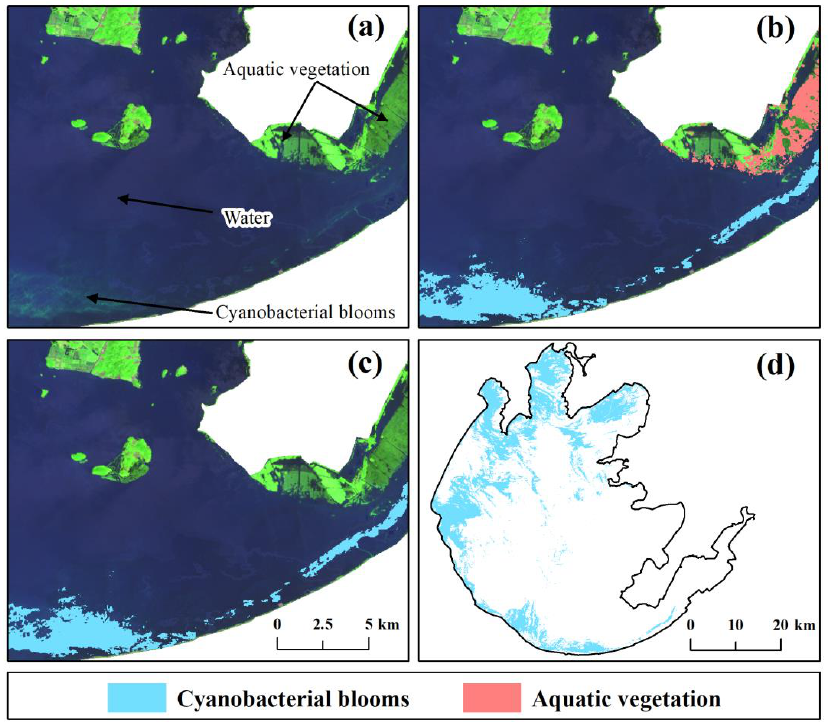
Figure 3. The cyanobacterial bloom extraction process in East Bay in 2021 ( a – c ) and final extraction results for the entire lake in 2021 ( d ). ( a ) Landsat annual mean composite imagery in 2021, R:G:B = band 6:5:4. ( b ) Landsat imagery overlapped with the initial extraction results of cyanobacterial blooms without manual modification (including aquatic vegetation and cyanobacterial blooms). ( c ) Landsat imagery overlapped with manually modified bloom extraction results (cyanobacterial blooms only).